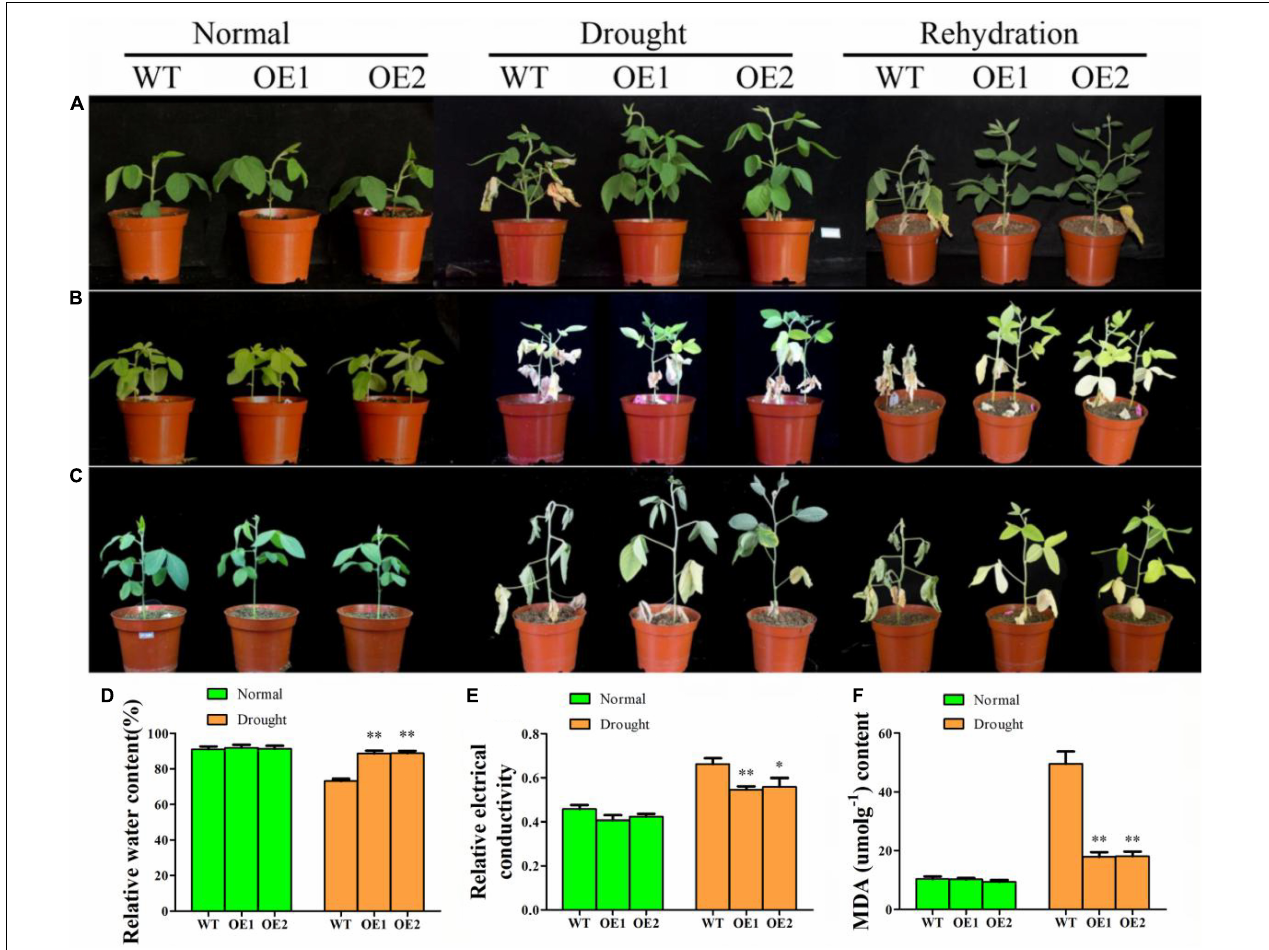
FIGURE 6 | The GmAP2/ERF144 acts as a positive regulator in response to drought stress. (A) Performance of wild-type (WT), and two GmAP2/ERF144 overexpressing lines (OE1 and OE2) under drought stress. Two-week-old plants were incubated at 18 days drought stress, and rehydration after drought. (B) Performance of wild-type (WT), and two GmAP2/ERF144 overexpressing lines under drought stress. Two-week-old plants were incubated at 16 days drought stress, and rehydration after drought. (C) Performance of wild-type (WT), and two GmAP2/ERF144 overexpressing lines under drought stress. Two-week-old plants were incubated at 28 days drought stress, and rehydration after drought. (D) The leaf relative water contents in different lines under drought stress. (E) Leaf relative conductivity in different lines under drought stress. (F) MDA content in different lines under drought stress ( n = 3). Data represent the mean ± SE. ∗ , P < 0.05 (Student’s t -test). ∗∗ , P < 0.01 (Student’s t